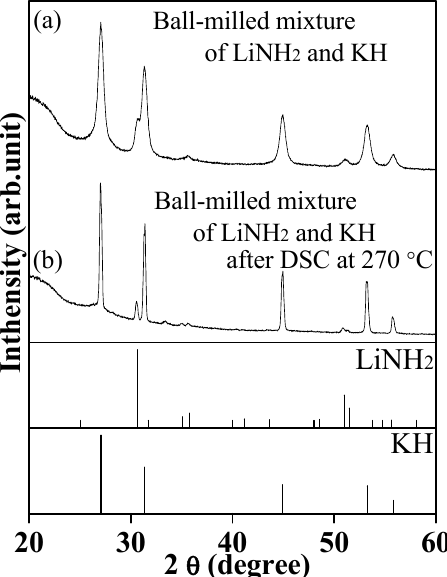
Figure 4. XRD patterns of the ball-milled mixture of LiNH 2 and KH before ( a ) and after ( b ) DSC measurement under H 2 atmosphere up to 270 ◦ C with a heating rate of 5 ◦ C/min; XRD patterns of LiNH 2 (PDF#75-0049) and KH (PDF#65-9244) are referred from databases.